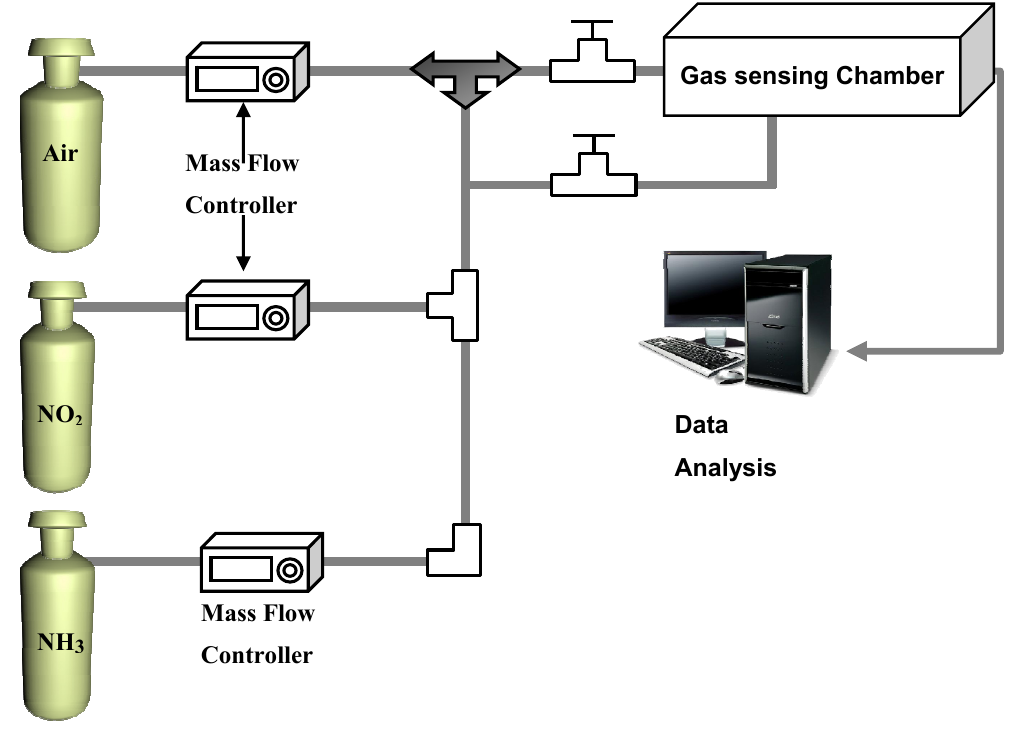
Figure 1. The experimental setup used in the gas